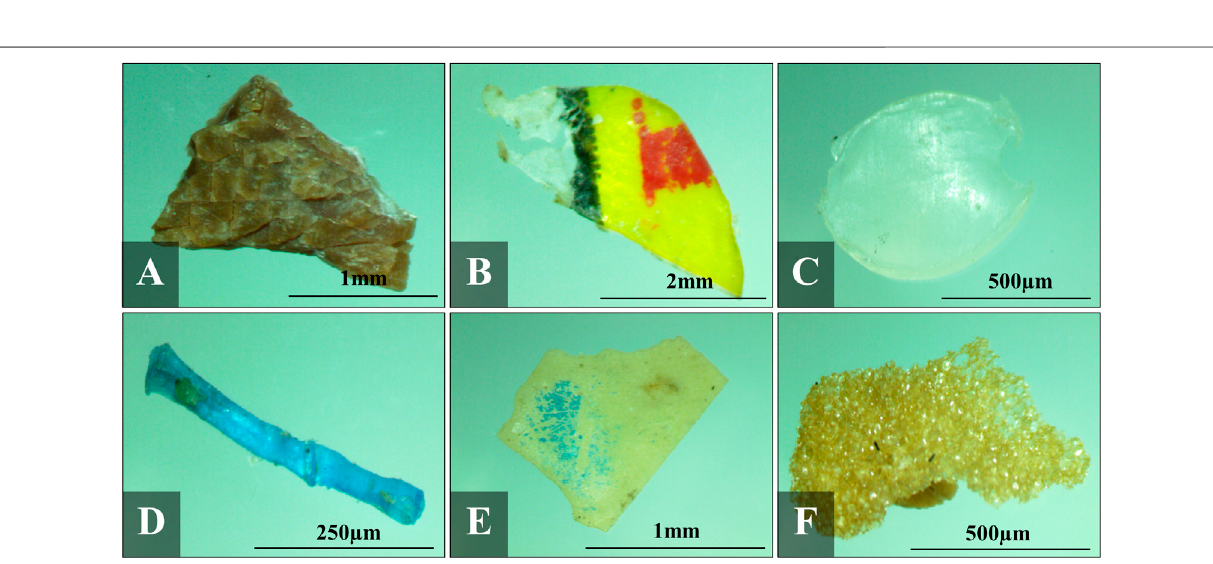
Frontiers in Environmental Science |